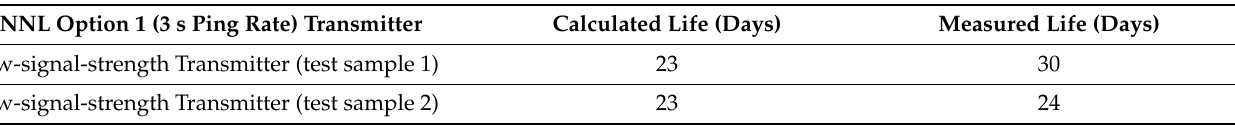
Table 1. The Prototype RF Transmitter Life Testing